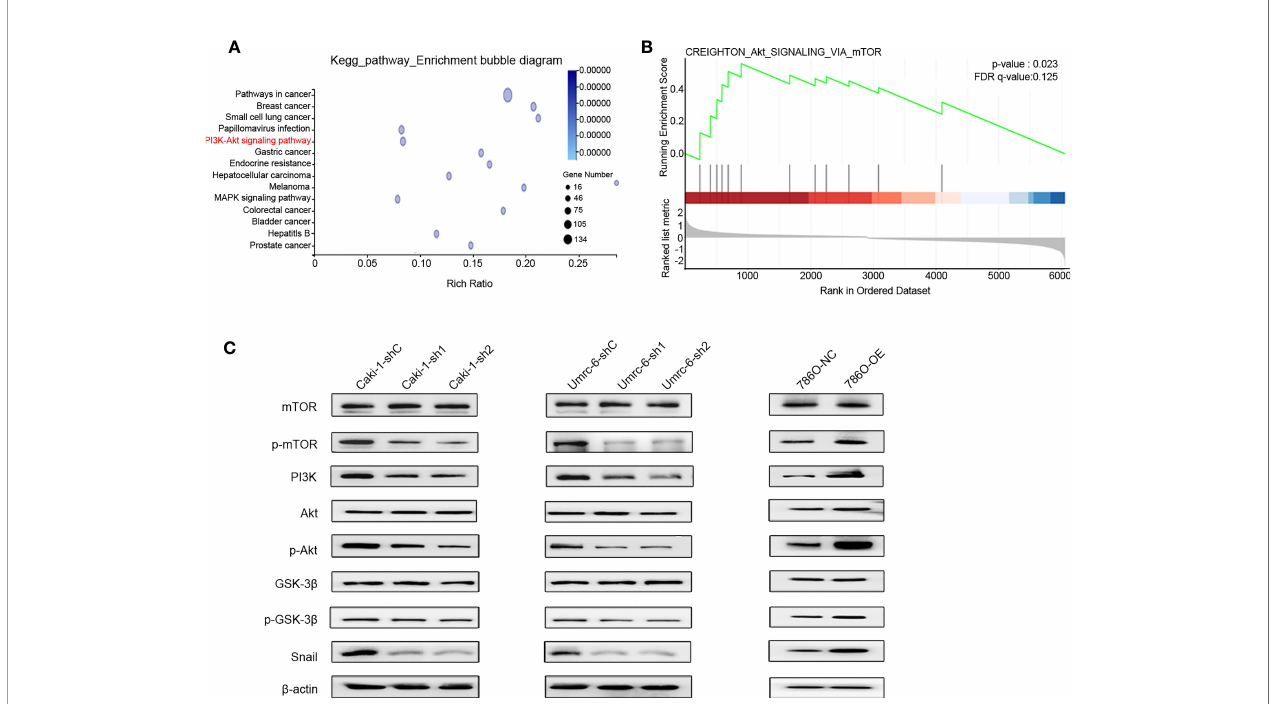
FIGURE 6 | DUXAP9 was involved with the Akt signaling pathway. (A) KEGG functional enrichment analysis showing that the differentially expressed genes between DUXAP9 knockdown and control groups were involved in the Akt signaling pathway, as detected by next-generation RNA sequencing of the cells. (B) Gene set enrichment analysis identi fi ed that DUXAP9 was associated with the Akt signaling pathway, based on RNA sequencing data from 445 localized ccRCC tissues from TCGA database. (C) Expression of Akt signaling pathway-related proteins in renal cancer cells in response to DUXAP9 overexpression or knockdown, as detected by western blotting. shRNA, short hairpin RNA; sh1, shRNA1; sh2, shRNA2; shC, shRNA negative control; OE, DUXAP9 overexpression; NC, overexpression negative control; KEGG, Kyoto Encyclopedia of Genes and Genomes; TCGA, The Cancer Genome